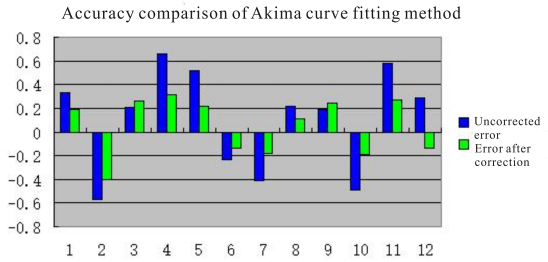
Figure 8 Accuracy comparison of Akima curve fitting method